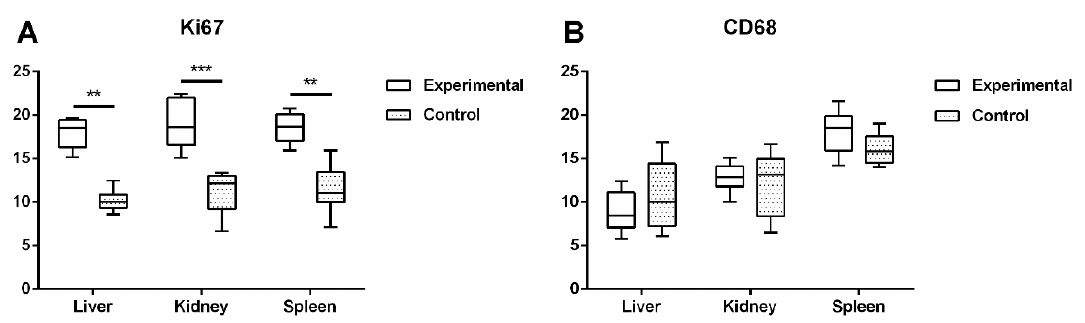
Figure 6. Percentage area of Ki67 ( A ) and immunoreactive CD68+ ( B ) stained cells was calculated with ImageJ using 3 images per organs ( t -test, ** p < 0.01, *** p < 0.001).